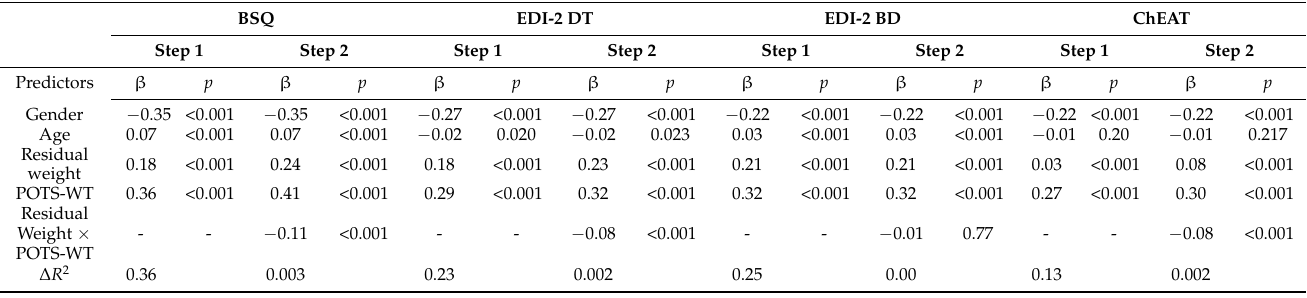
Table 2. Hierarchical regression analyses in the adolescent